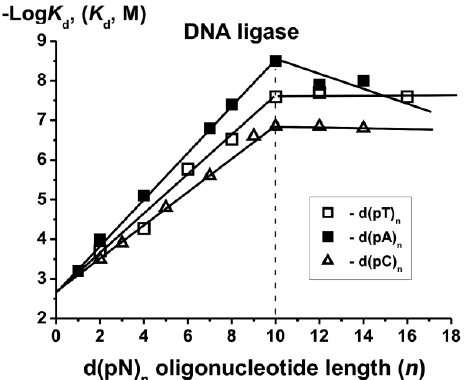
Figure 9. Dependencies of −Log K d for ss and ds d(pN) n deoxyribooligonucleotides versus their length ( n ) in the case of DNA ligase [12,13].